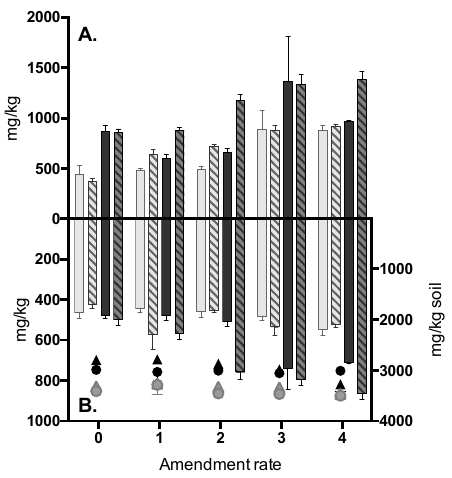
Figure 5. The magnesium concentration of shoots ( A ) and roots ( B ) grown in Freeman (light grey) or Bernhill (dark grey) soils amended with KB- (solid) or wood- (cross- hatched) sourced biochars. The aluminum of the soils (right axis, (B)) is also plotted for Freeman (light grey) or Bernhill (dark grey) soils amended with KB- (circle) or wood- (triangle) sourced biochars (Trippe 2015). Amendment rates are represented as 0–4, which correspond to rates of 0%, 3%, 6%, 16%, and 25% by volume for both biochars, 0%, 0.7%, 1.7%, 3.7%, and 8.6% by mass for wood biochar, and 0%, 0.4%, 1.2%, 2.5%, and 5.8% by mass for KB-sourced biochar.